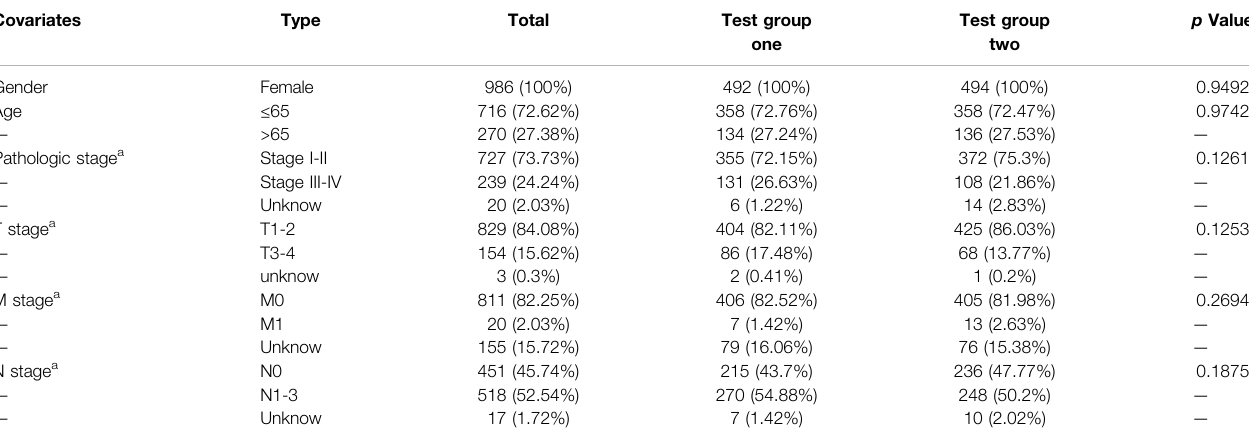
TABLE 4 | Clinical characteristics of the two validation subgroups from the dataset of 986 samples.